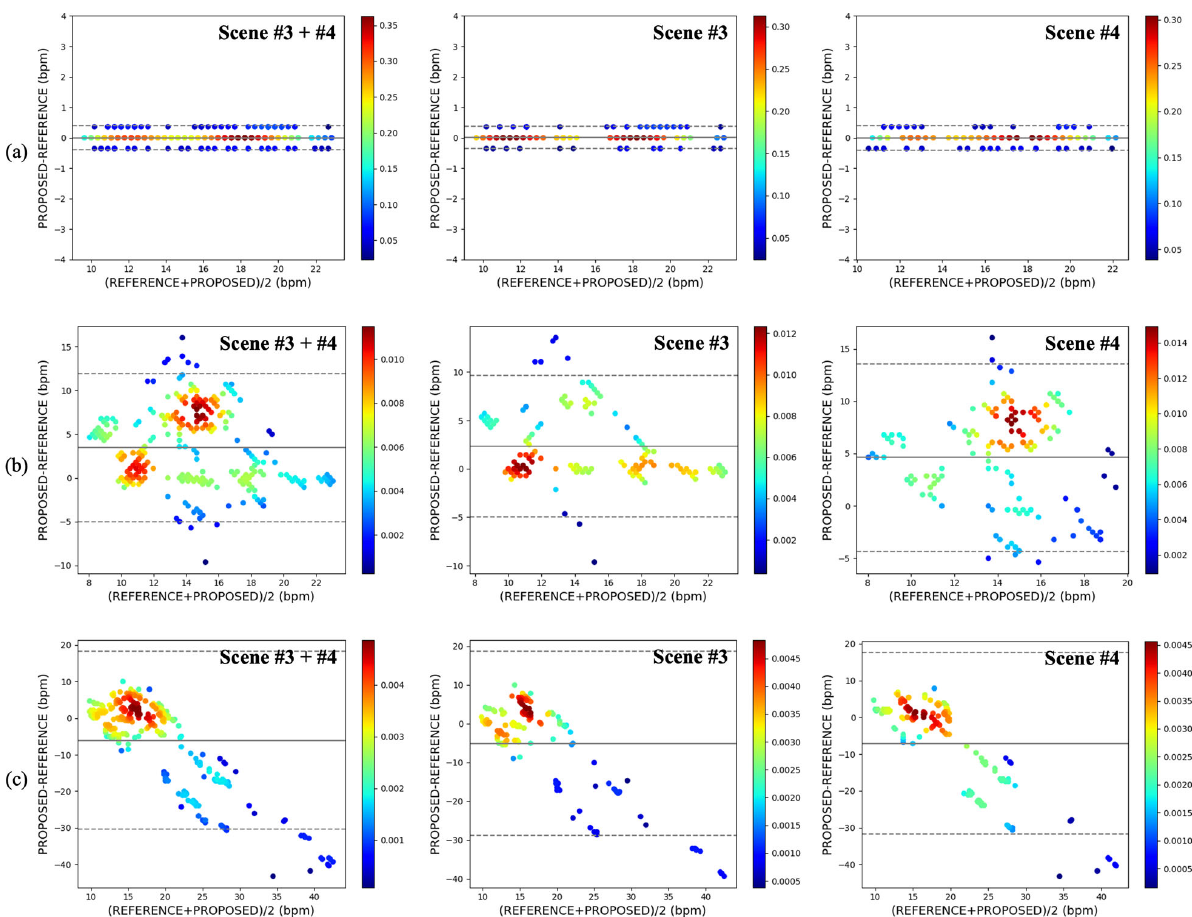
Figure 13. Bland-Altman plot of three respiration estimation methods for scene #3, #4: ( a ) ours, ( b ) optical flow-based, and ( c ) intensity-based. Table 6. Respiration measurements in environments with motion noise.